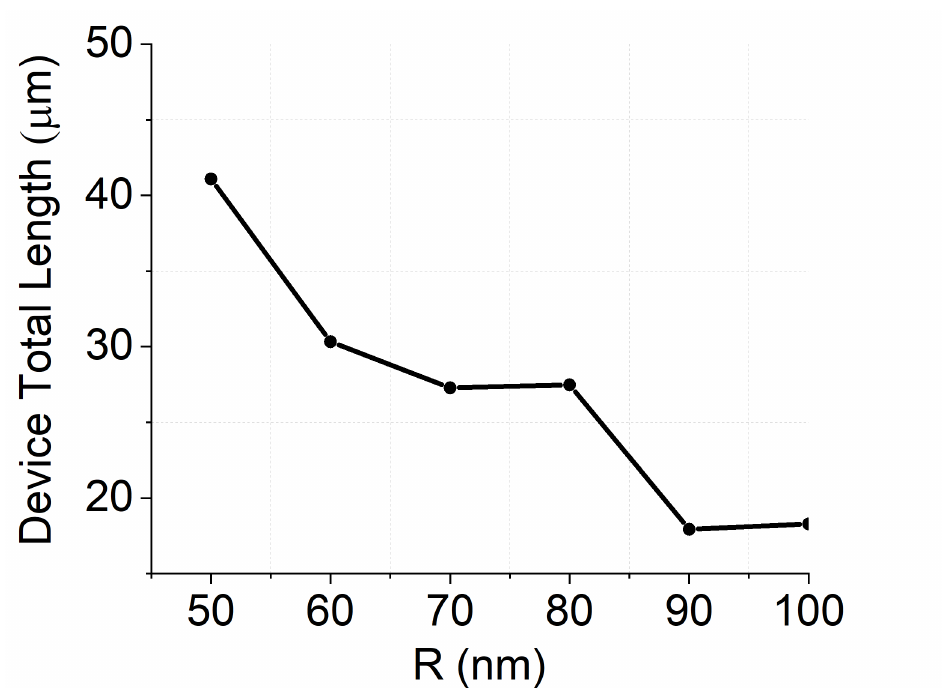
Figure 6. Calculated device total length for different R configurations.